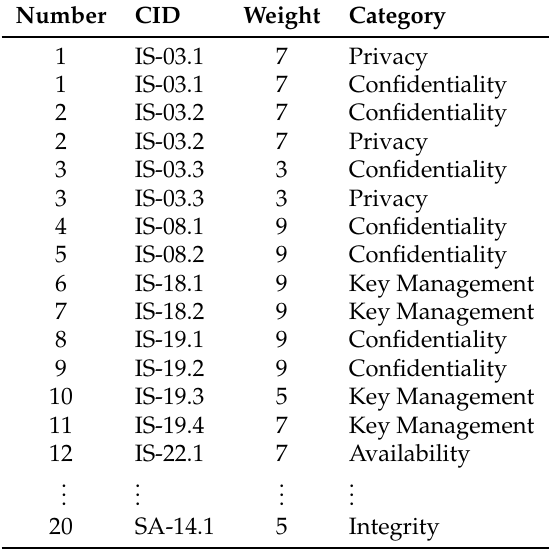
Table A1. Weighted Mapping from Questions to